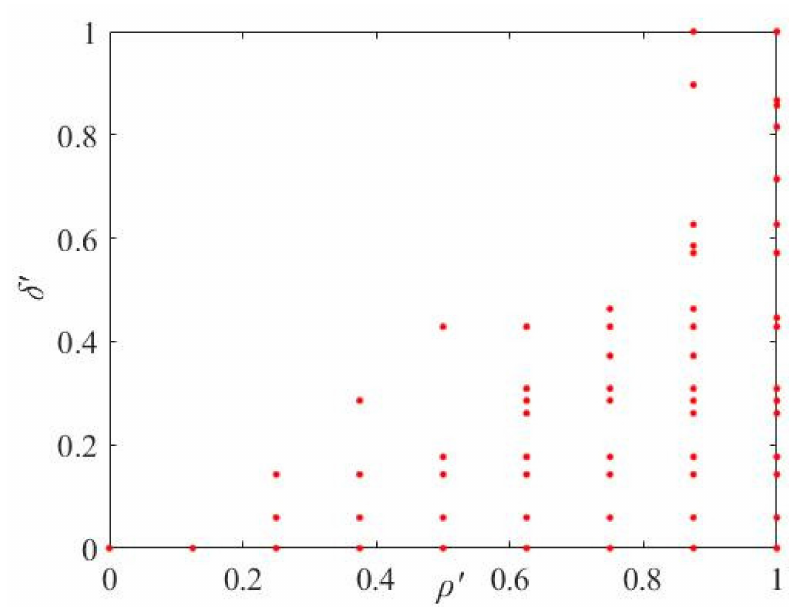
Figure 5. The distribution of all the feature points in the ρ (cid:48) – δ (cid:48) coordinate system. It can be seen from Figure 5 that the larger the ρ (cid:48) and δ (cid:48) of the points are, the more likely it is that the points are distributed in the upper right part of the coordinate system. In other words, the points in the upper right part are the candidates for cluster centers. For extracting the cluster centers from the points, the following two Equations (10) or (11) are used to determine which ones are the cluster centers in this